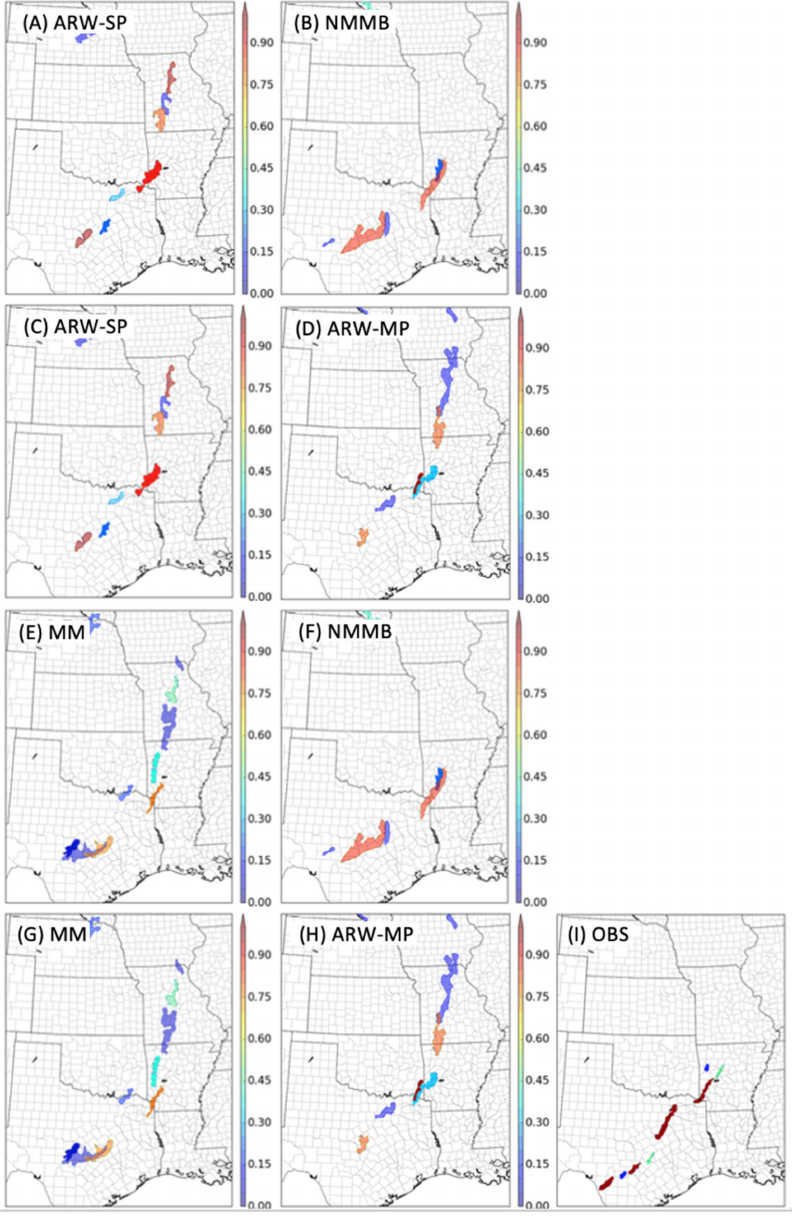
Figure 8. OBPROB plots for ensemble-to-ensemble comparisons from the 16 May 2015 case study, valid at 01 Z. Each ensemble-to-ensemble comparison is organized by column: SMSP ( A , B ), SPMP ( C , D ), MMSM ( E , F ), and MPMM ( G , H ). Objects with transparency of 1.0 are matched to observations, and objects with 0.5 transparency are not. As in Figure 4, observation plot ( I ) object colors indicate a convective scale